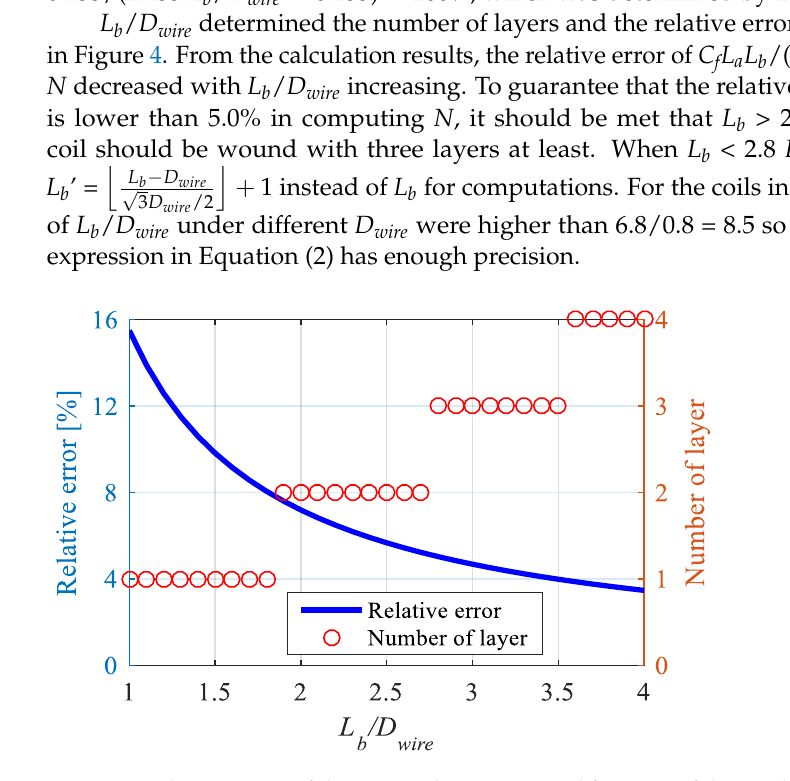
Figure 4. Relative errors of the positively proportional function of the available area of coil skeleton vs. the cross-sectional area of enameled wire.